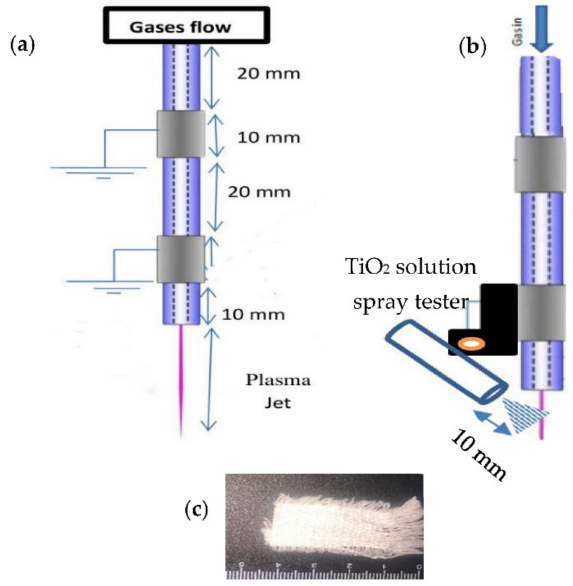
Figure 1. ( a ) Experimental setup of dry Ar-APPJ discharge, ( b ) wet Ar-APPJ discharge, and ( c ) the woven cotton fabric control (untreated